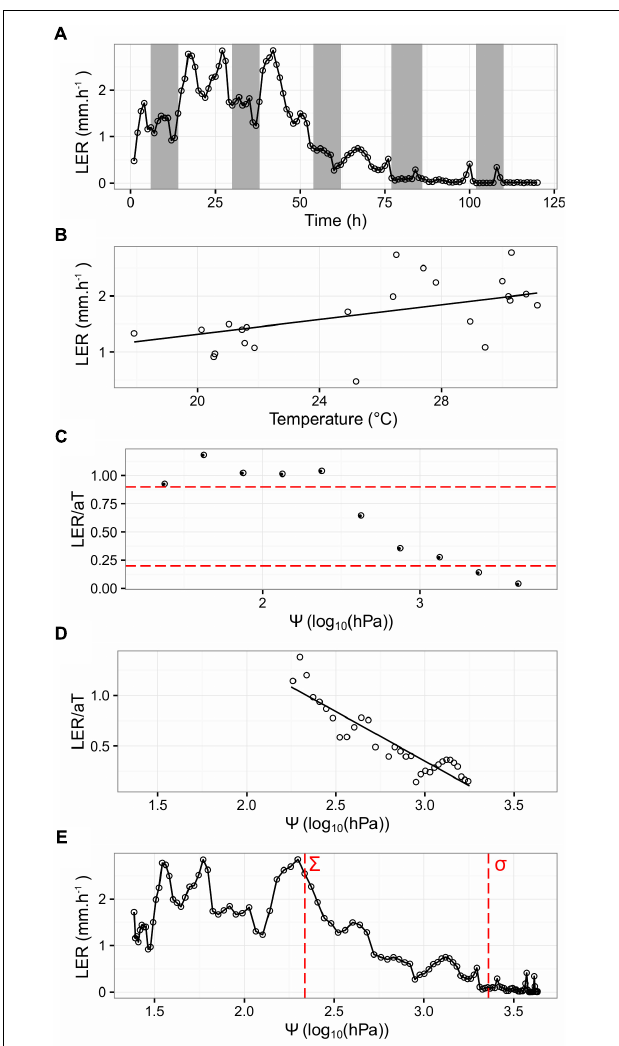
FIGURE 3 | Parameter determination of the Tri-Phase function, illustrated on a single tiller from one clonal replicate of the “Arara B” genotype. (A) Shows the LER, summarized hourly over a period of 120 h (hollow circles). Night periods are indicated with gray shading. (B) Shows LER, plotted against the meristem temperature (T) from the first 24 h of the experiment (hollow circles). The fitted regression (a) is given as a black solid line and intercepts at 0. (C) Shows the normalized growth rate (LER/aT) per quarterly soil moisture ( (cid:57) ) interval (circles). The red dashed lines represent cutoff values of 0.9 and 0.2 LER/aT. (D) Shows hourly LER, plotted against (cid:57) from the filtered data (0.2 < LER/aT < 0.9). The linear regression of the hollow circles is given as a solid black line. (E) Shows LER, plotted against (cid:57) with estimated (cid:54) and σ , demarcating where LER decreases and stops, shown as vertical red dashed lines at 2.4 and 3.4 log 10 (hPa), respectively.